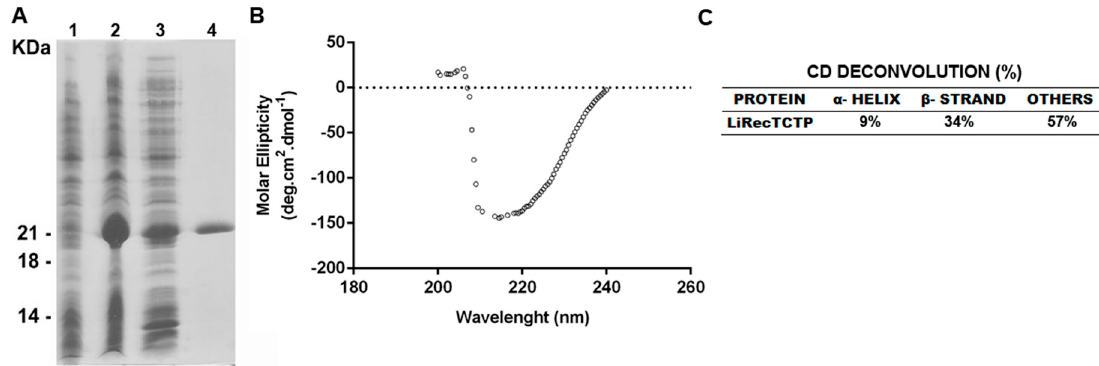
Figure 1. Heterologous expression, purification, and circular dichroism spectroscopy CD analyses of recombinant LiTCTP. ( A ) SDS-PAGE (12.5%) analysis of recombinant LiTCTP toxin expression stained with Coomassie blue dye. Lane 1 show E. coli BL21 (DE3) pLysS cells before induction with IPTG. Lane 2 shows E. coli BL21(DE3) pLysS after induction for 4h with 0.1 mM isopropyl-d-thiogalactoside (IPTG) (supernatant from cell lysates obtained by freezing and thawing in extraction bu ff er before incubation with Ni 2 + -NTA beads). Lane 3 depicts the void from Ni 2 + -NTA chromatography. Lane 4 shows eluted recombinant protein from Ni 2 + -NTA beads. Molecular mass markers are shown on the left. ( B ) The UV-CD spectrum was obtained in a Jasco J-810 spectropolarimeter (Jasco Corporation, Tokyo, Japan) by diluting the sample at 0.5 mg / mL in phosphate bu ff er, pH 7.4 at 20 ◦ C. Graphic representation was plotted using GraphPad Prism 6. ( C ) The deconvolution of data, α -helix and β -sheet percentages of LiRecTCTP structure was calculated using K2D3 tool.